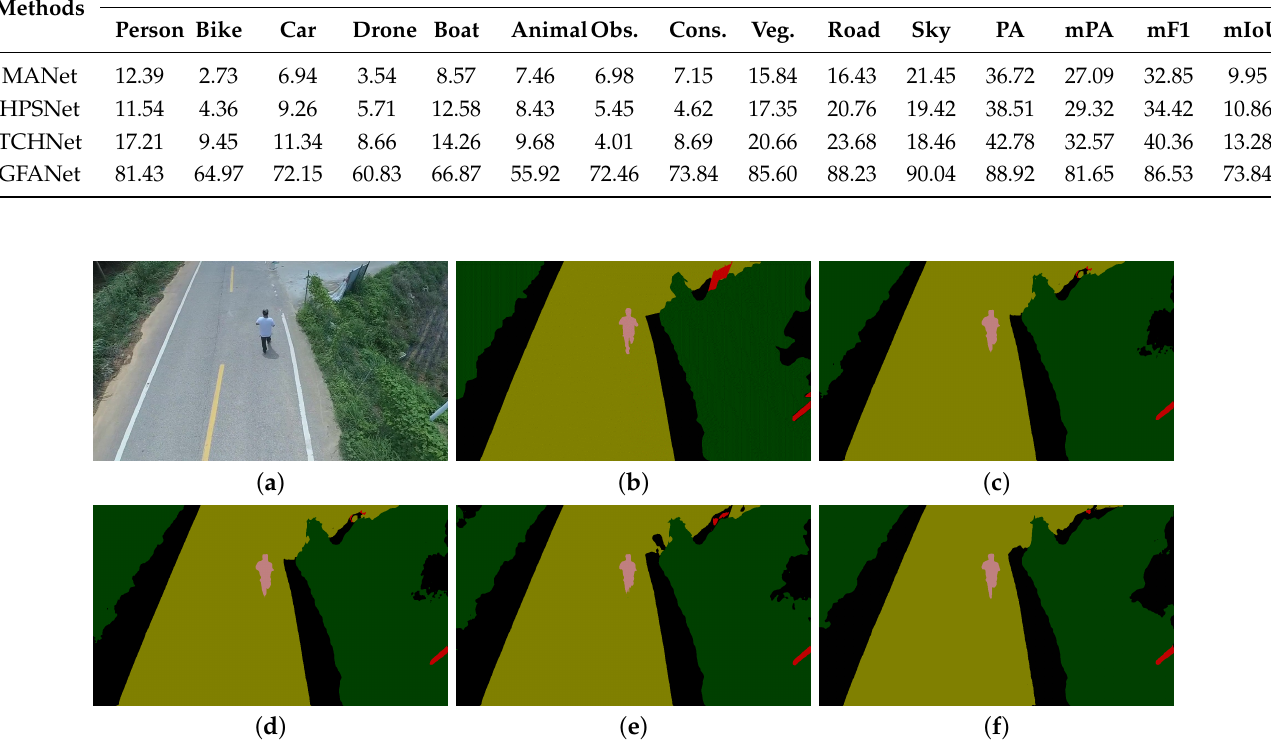
Figure 9. Visualization results of different methods on the clean example test set in the AeroScapes dataset. ( a ) Original Images. ( b ) Ground Truth. ( c ) MANet [16]. ( d ) HPSNet [17]. ( e ) TCHNet [70]. ( f ) GFANet.